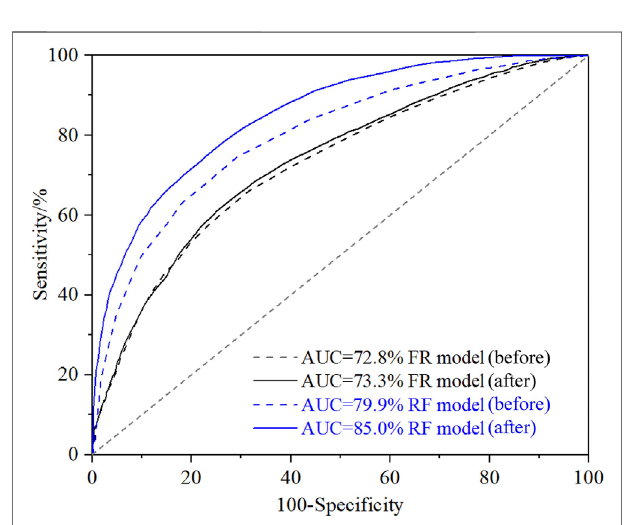
FIGURE 4 | Coxcomb chart of PDTD and FR. (A) Altitude; (B) rivers.